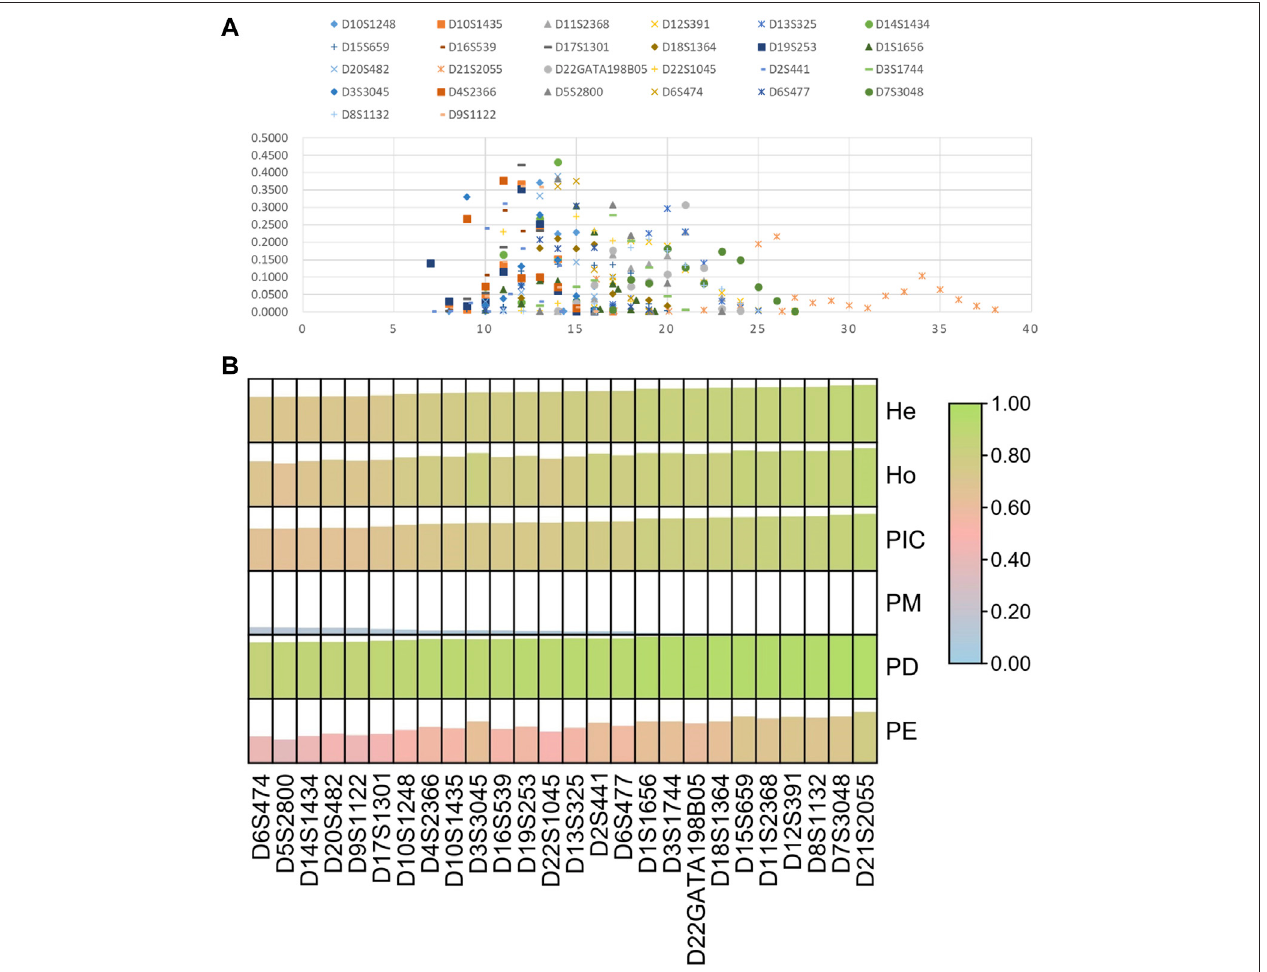
FIGURE 7 | Allelic frequencies (A) and forensic parameters (B) of 26 STRs in the Guizhou Han population.